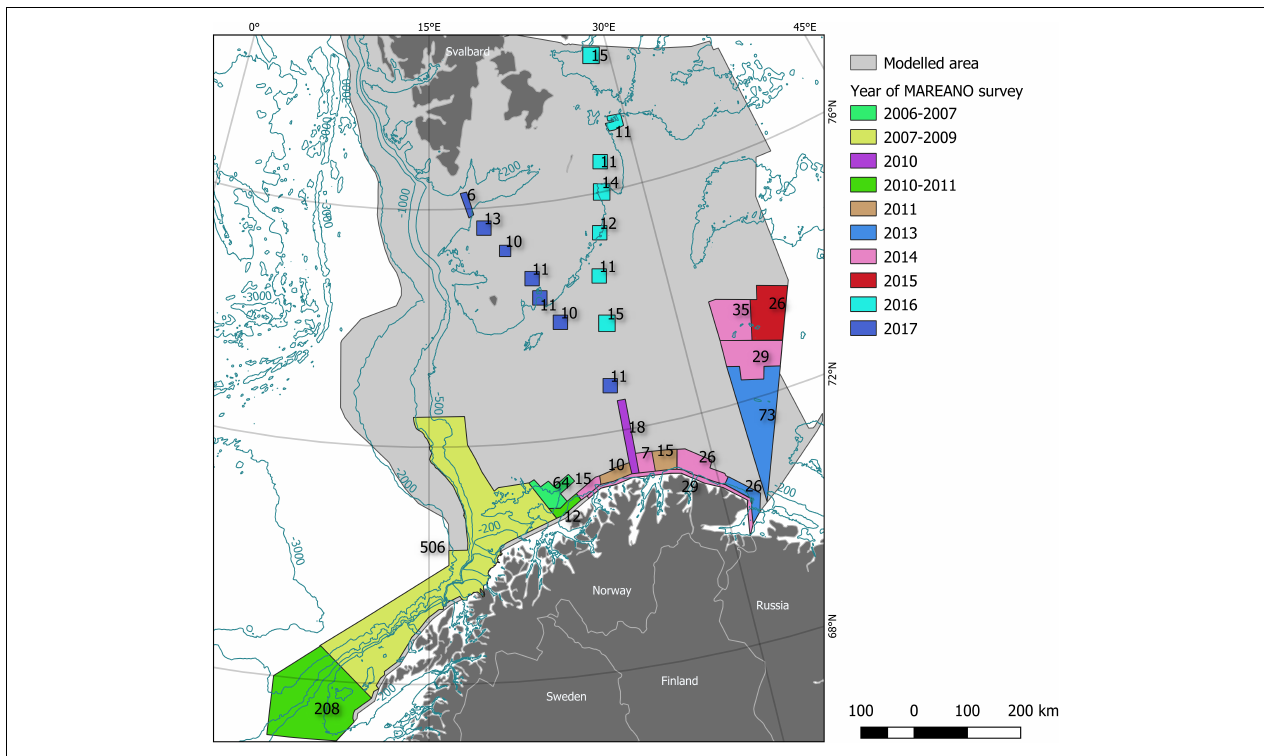
FIGURE 1 | The faunal data used in this study were collected under the Marine AREAl database for NOrwegian waters (MAREANO) Programme. Under this government-funded, data collection programme, benthic sampling is conducted according to predefined survey areas. In this figure, we illustrate the number of video stations per survey area (labels on the map), as well as the year when the sampling was carried out (see legend for details), for the surveys that were used in this study in the Barents Sea. Also shown are bathymetric contour lines (dark blue) and land masses with political boundaries (gray). The scale on this map (scale bar) is 1:5,745,500.